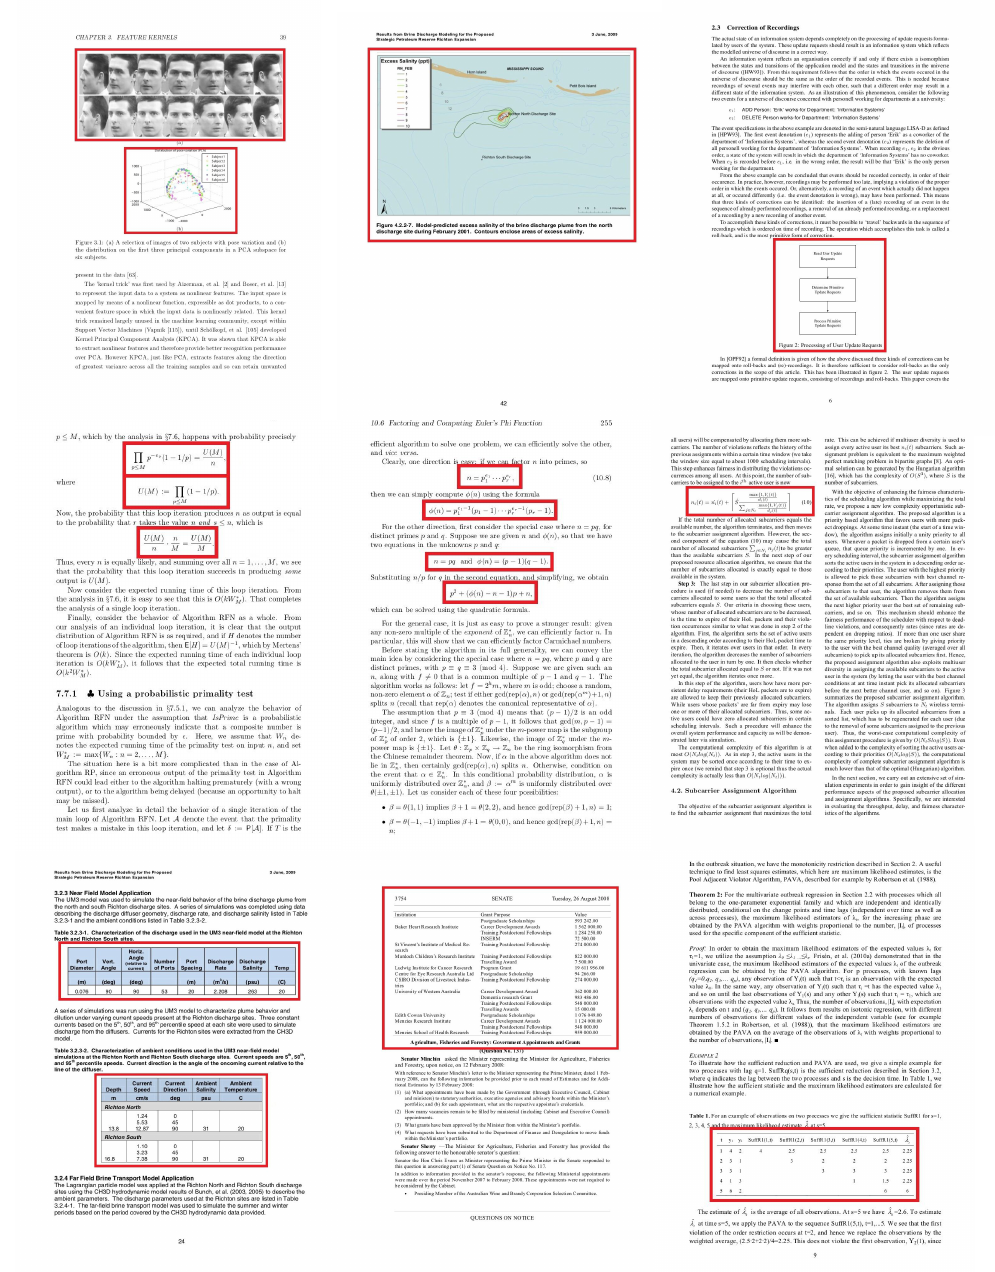
Figure 1. Demonstration of the problem of graphical page object detection in document images. First Row : figure detection in document images. Second Row : detection of single and multiple formulas in document images. Third Row : localization of tabular areas in document images. The samples are taken from the dataset of ICDAR-17 POD